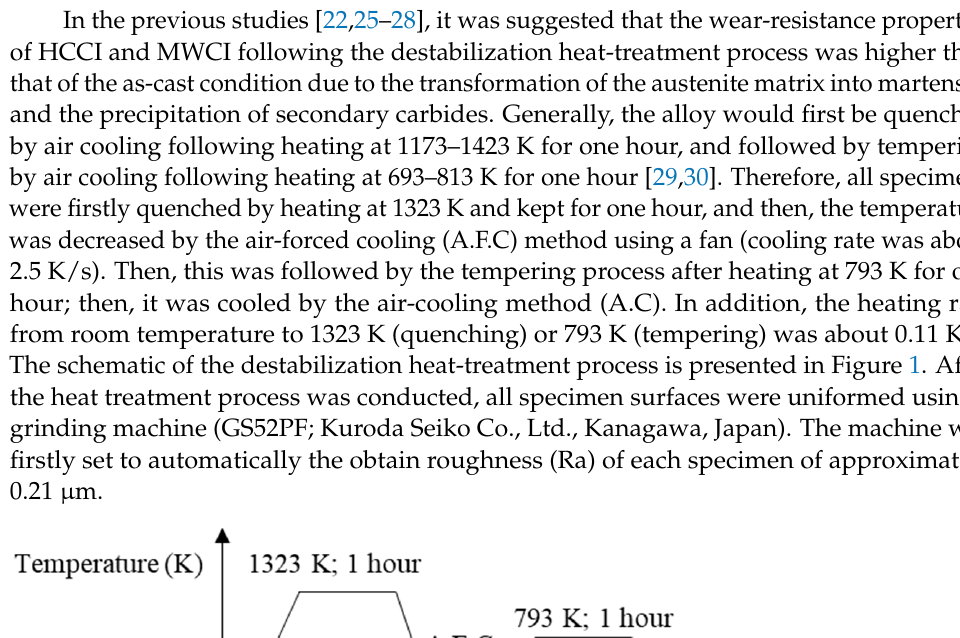
Table 1. Chemical composition of each specimen (wt.%).